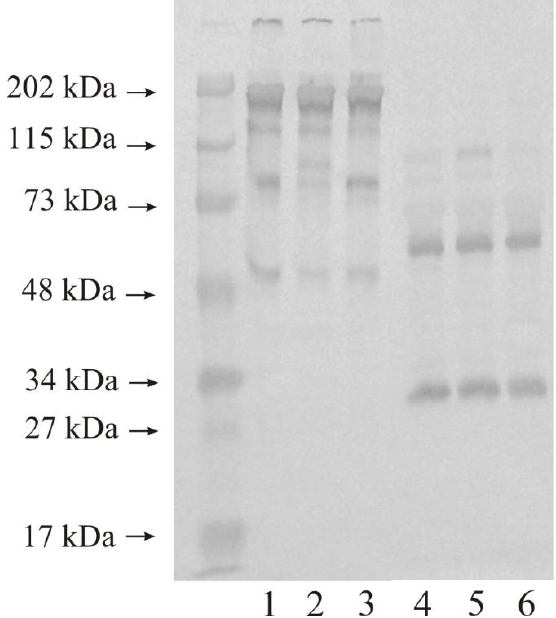
Figure 4. Western immunoblot of MMP-9 in control tissue and low-grade (LG) and high-grade (HG) urinary bladder cancer. A total of 10 micrograms of protein, non-reducing condition: lane 1 — control urinary bladder, 2 — low-grade bladder cancer, 3 — high-grade bladder cancer; 10 micrograms of protein, reducing condition: lane 4 — control urinary bladder, 5 — low-grade bladder cancer, 6 — high-grade bladder cancer. It is a typical example of the WBs of the samples repeated five times.